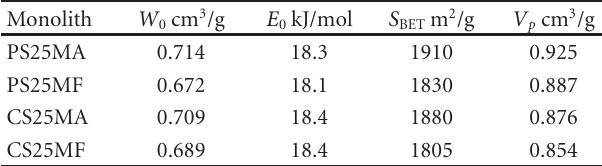
Figure 4: Scheme of equipment for measuring the heat of wetting: 1-calorimetric cell, 2-container of methanol, 3-electronic system to temperature measurement, 4-vacuum pump, 5-control vessel, 6- filter. Table 2: Structural properties of monoliths.